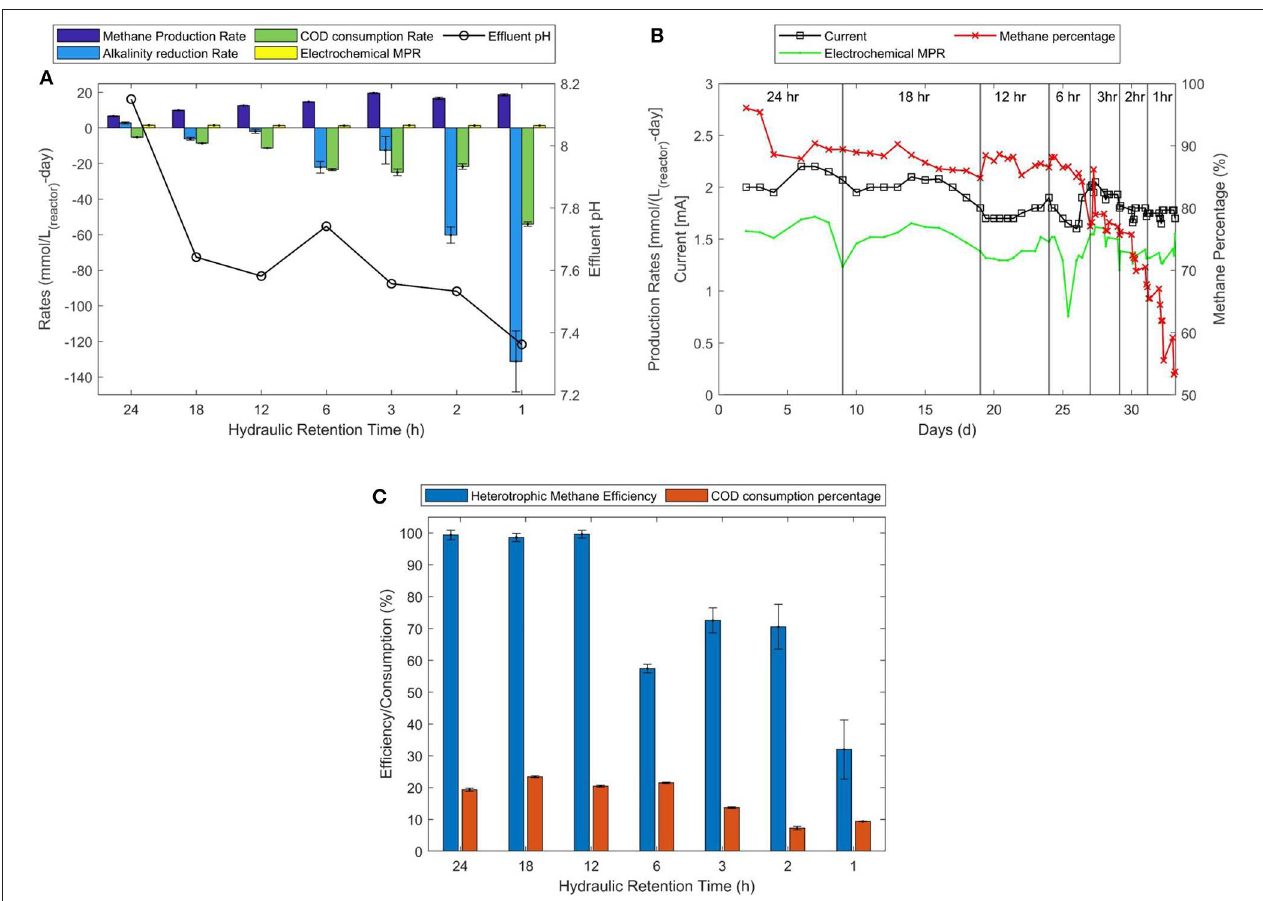
FIGURE 3 | HRT experiments conducted with feed containing no acetic acid. (A) Overall and electrochemical methane production rates, methane percentage in the biogas and current measured. (B) Average overall and electrochemical methane production rates, rates of changes in COD and alkalinity. (C) Amount COD consumed and the heterotrophic efficiency to produce